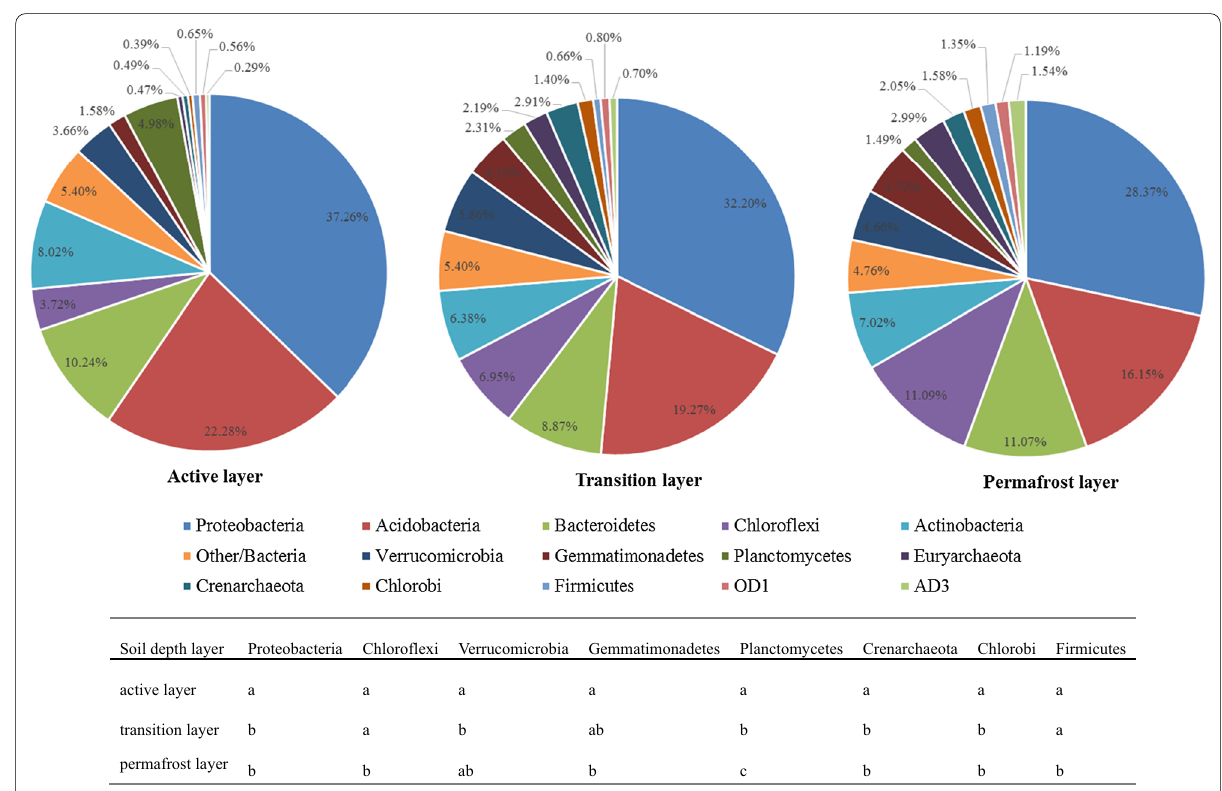
Fig. 2 Relative abundance of dominant microbial phyla in different soil layers. The differences in relative abundance for each phyla among soil layers were analyzed using a one-way analysis of variance. Values of microbial phyla significantly different ( P < 0.05, Tukey’s HSD) are shown in the table with contrasting letters